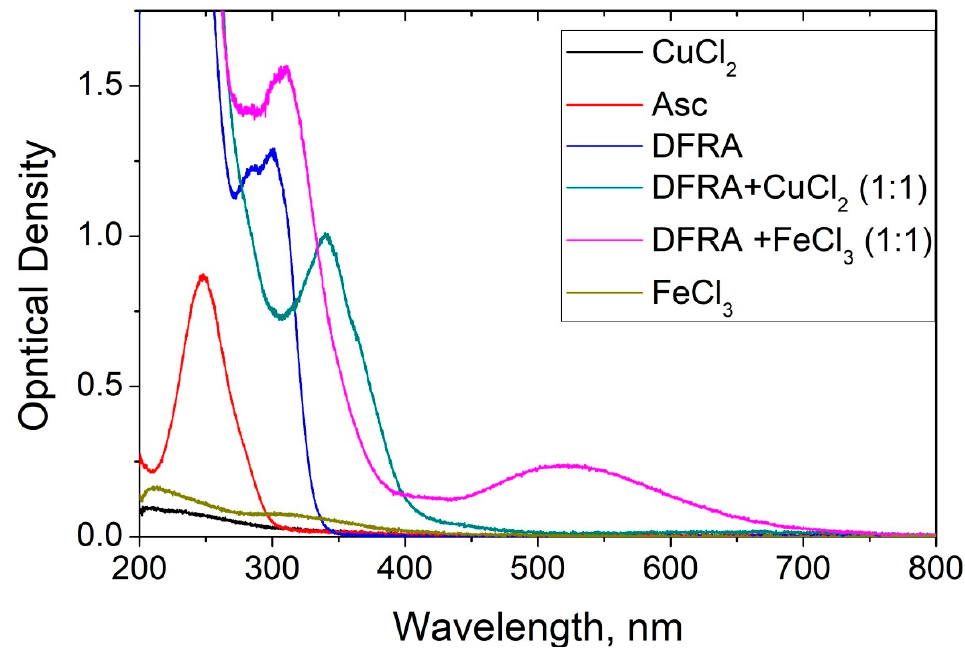
Figure 2. UV-Vis absorption spectra of deferasirox (DFRA, 0.1 mM), its chelate complexes with Fe 3+ (0.1 mM) and Cu 2+ (0.1 mM), FeCl 3 (0.01 mM), CuCl 2 (0.02 mM) and ascorbic acid (Asc, 0.1 mM) in ethanol solution.